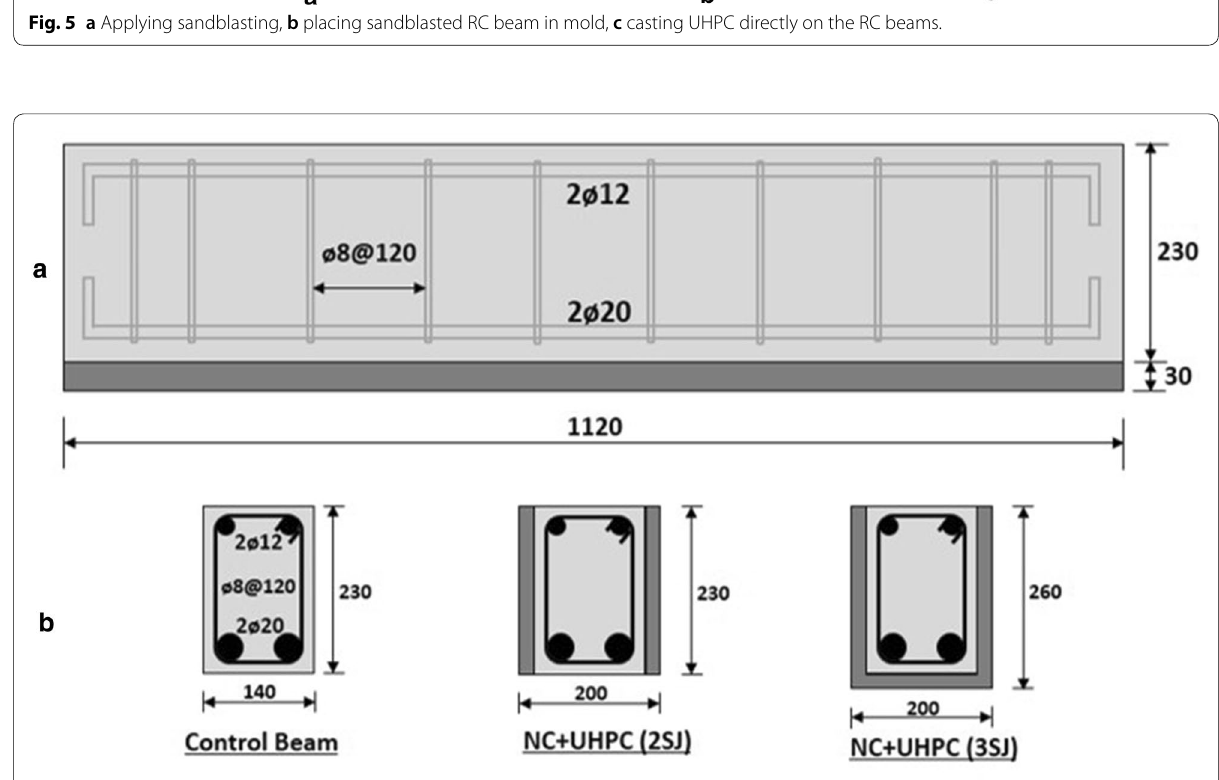
Fig. 6 a RC beam details, b strengthening configurations (all dimensions in